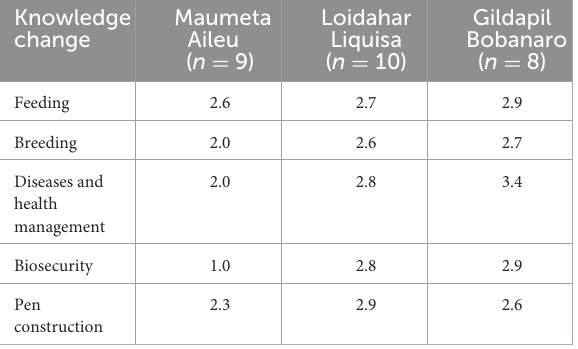
TABLE 8 Self-reported change in knowledge from farmer training ( N = 27) (mean values). Knowledge